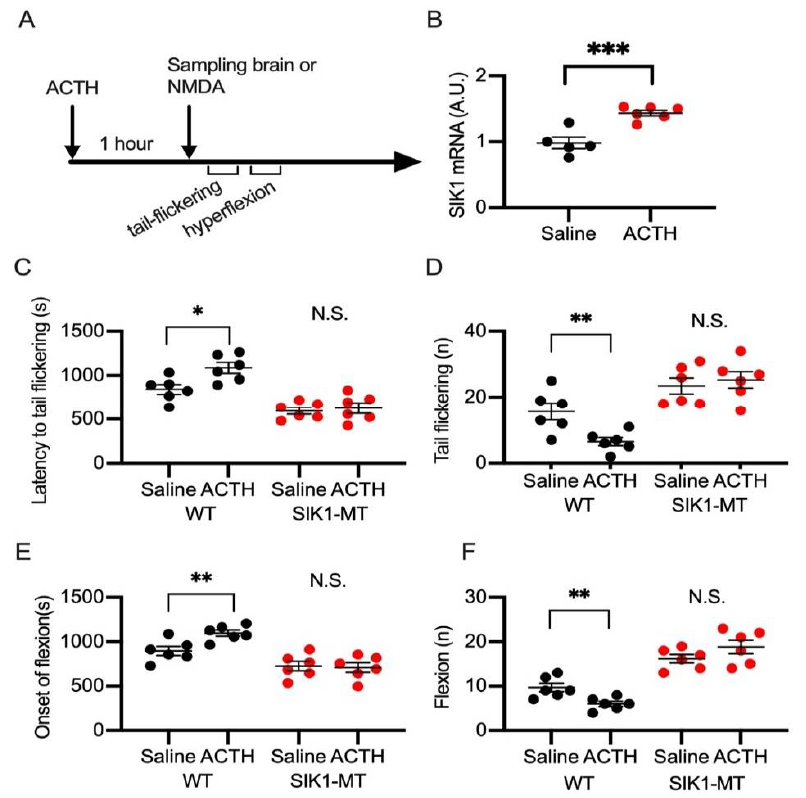
Figure 5. Pretreatment with ACTH is ineffective in NMDA-induced seizures in SIK1-MT mice. ( A ), Time course of ACTH pretreatment in NMDA-induced seizures. ( B ) Levels of SIK1 mRNA estimated by RT-qPCR. ACTH pretreatment increased the levels of SIK1 mRNA in the brain. ( C ) Summary graph for latency to tail flickering with pretreatment of saline or ACTH in wild-type and SIK1-MT mice. Decreased latency to tail flickering in SIK1-MT mice was not recovered by pretreatment with ACTH. ( D ) Summary graph for number of tail flickerings with pretreatment of saline or ACTH in wild-type and SIK1-MT mice. Increased number of tail flickerings in SIK1-MT mice was not recovered by pretreatment with ACTH. ( E ) Summary graph for latency to flexion with pretreatment of saline or ACTH in wild-type and SIK1-MT mice. Decreased latency to flexion in SIK1-MT mice was not recovered by pretreatment with ACTH. ( F ) Summary graph for number of hyperflexions with pretreatment of saline or ACTH in wild-type and SIK1-MT mice. Increased number of hyperflexions in SIK1-MT mice was not recovered by pretreatment with ACTH. Data are described in a scatter plot of each value with means ± SEM. Statistical analyses were performed by Student’s t -test (* p < 0.05; ** p < 0.01; *** p < 0.005; N.S. = not